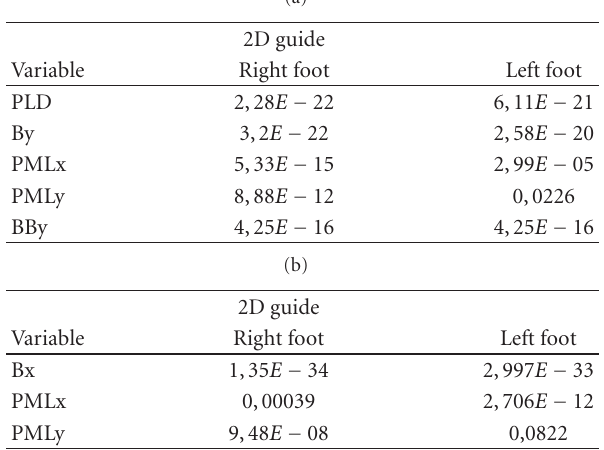
Table 6: ANOVA test analysis sample of the most repeatable features. (a) Male subjects, (b) female